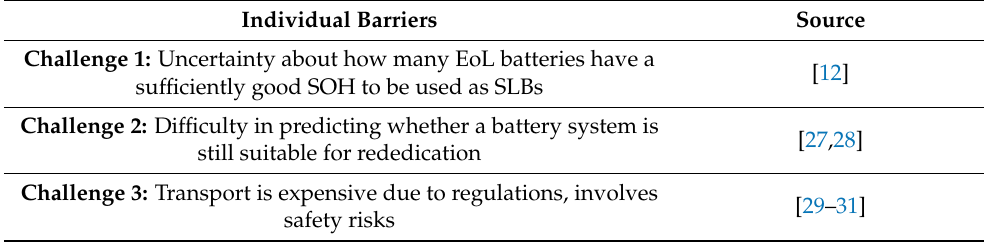
Table 1. The main barriers regarding end of first life, collection, and transport. Individual